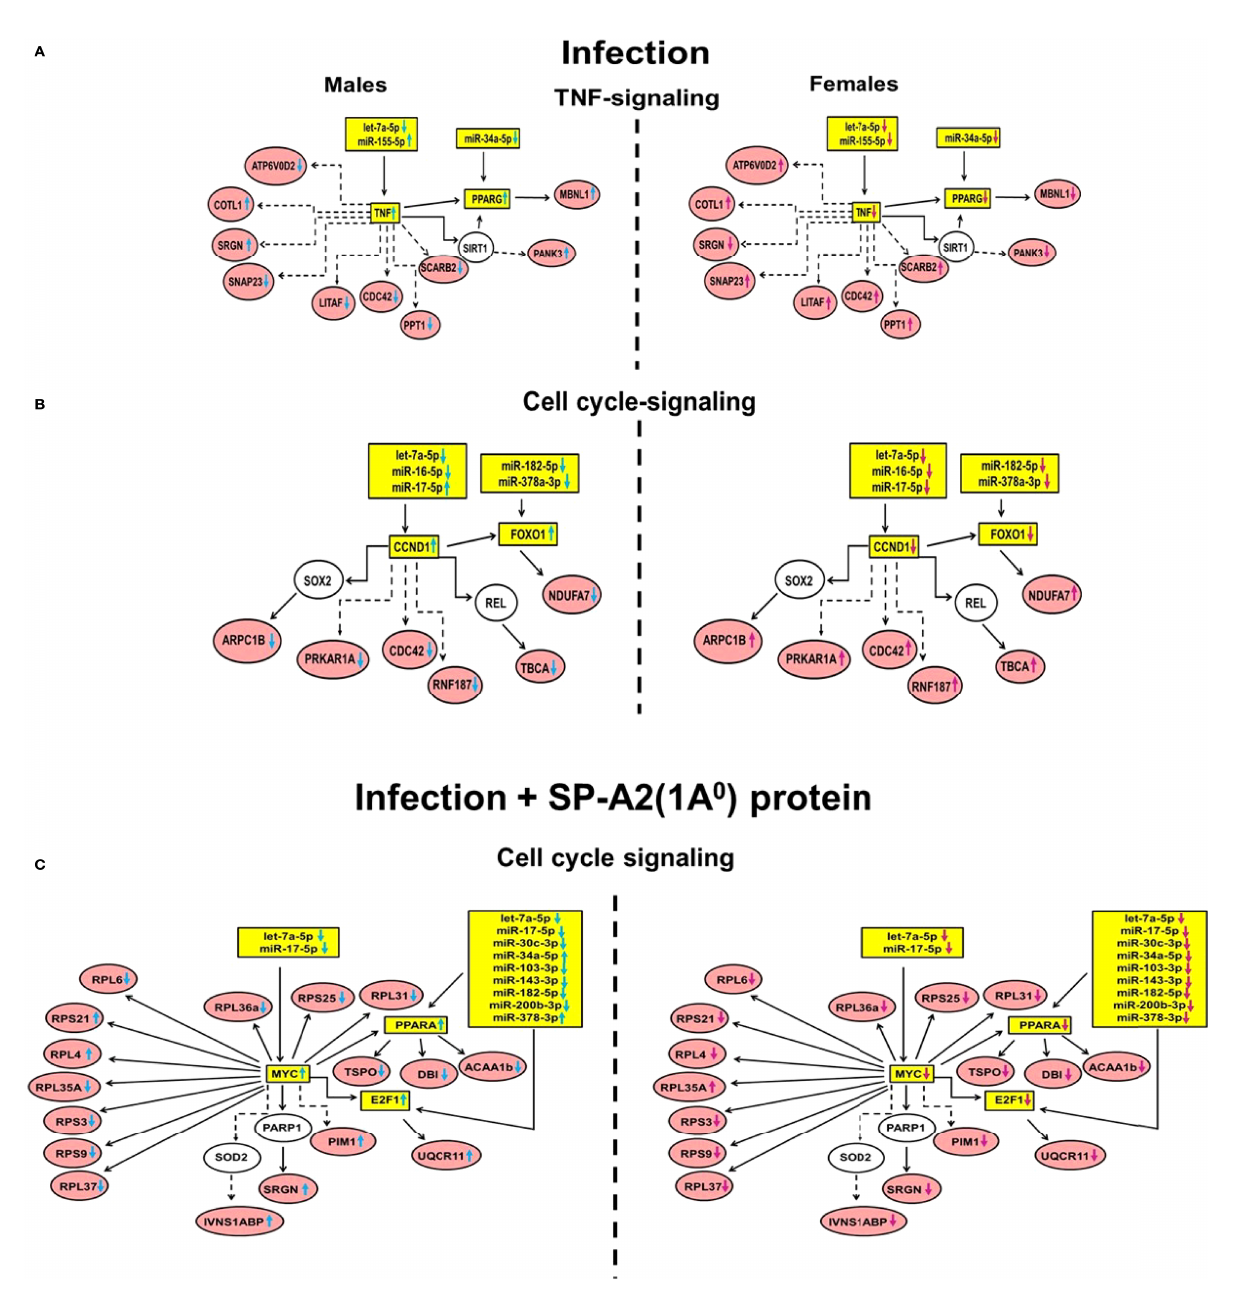
FIGURE 6 | Signi fi cant pathways that involve miRNAs, miRNA-mRNA targets and genes expressed following infection (Panel A, B ) and infection plus SP-A2 (1A0) protein rescue (Panel C ) are shown for males (left side diagrams) and for females (right side diagrams). Interactions of miRNA targets with genes identi fi ed from the gene expression analysis are shown. The molecules in these interactions are involved in the TNF and cell signaling pathways (p < 0.05). The miRNAs and their targets validated by qRT-PCR are highlighted in yellow. The genes that interact with miRNA targets are highlighted in red, and genes not identi fi ed in our study but exhibited interactions with the identi fi ed genes are shown in white. Direct and indirect interactions are shown with solid and dashed lines, respectively. The up and downregulation of miRNAs and genes are shown in blue and pink colored arrows indicating males and females,